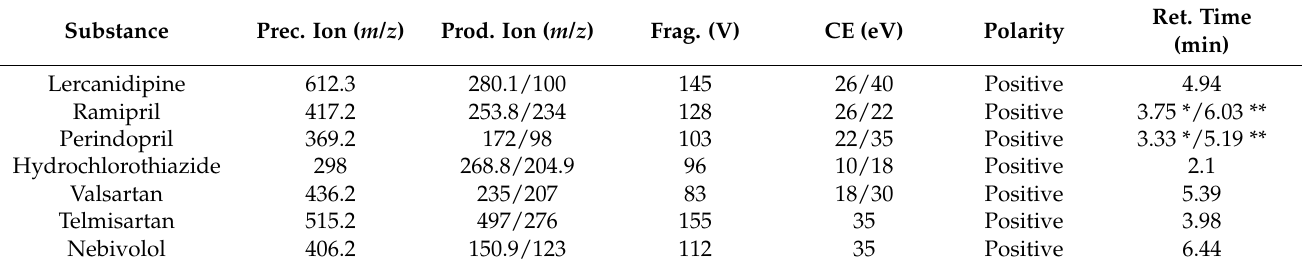
Table 7. (Multiple reaction monitoring (MRM)